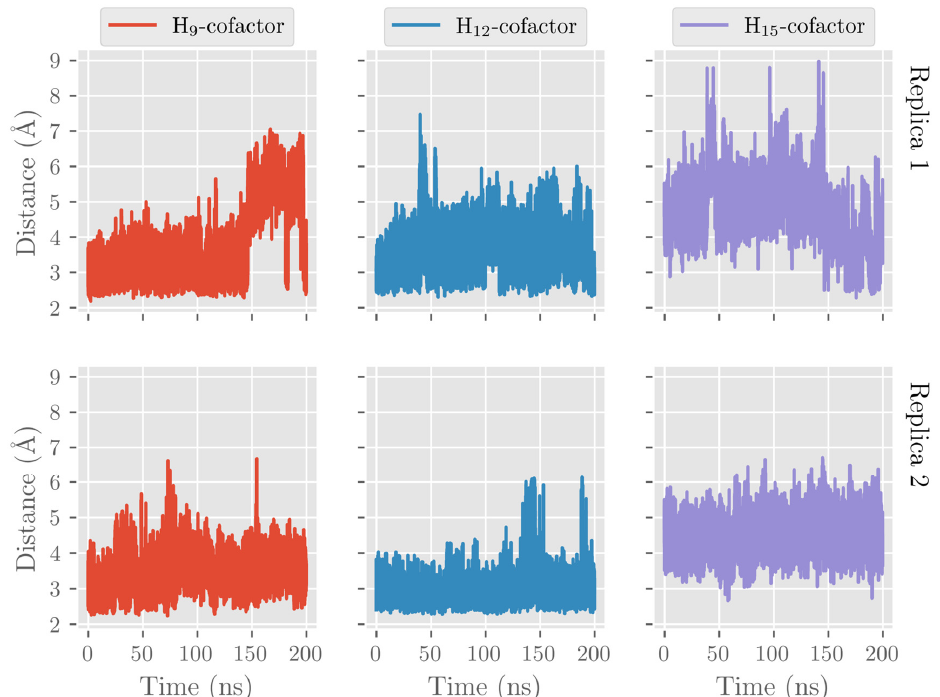
Figure 9. Evolution with time of the H 12 -OH − , H 9 -OH − , and H 15 -OH − distances along the MD replica 1 and replica 2 in hALOX12.